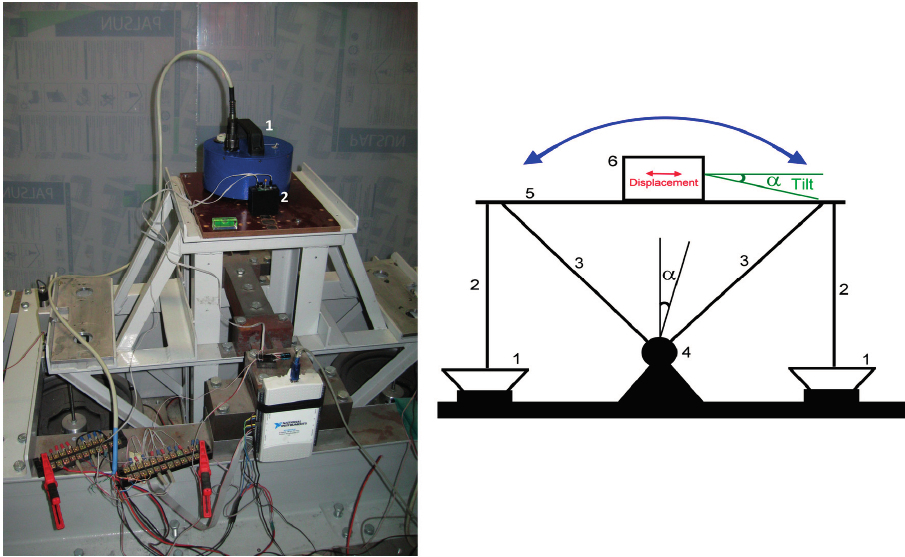
Figure 12. Low frequency response calibration. Marked on the left side are the hybrid accelerometer (1) and the MEMS on a pedestal (2).